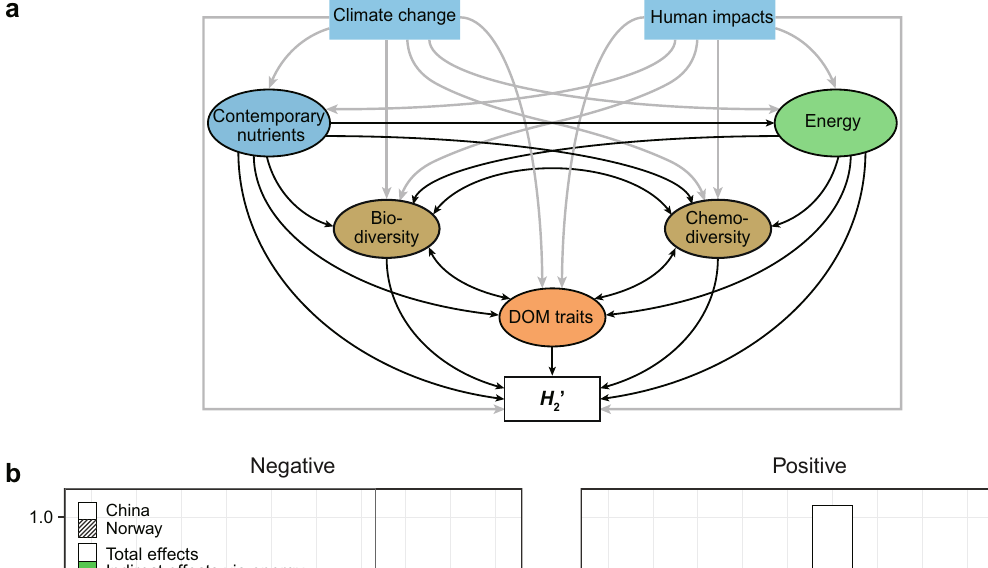
′ of negative (left panel) and positive 2